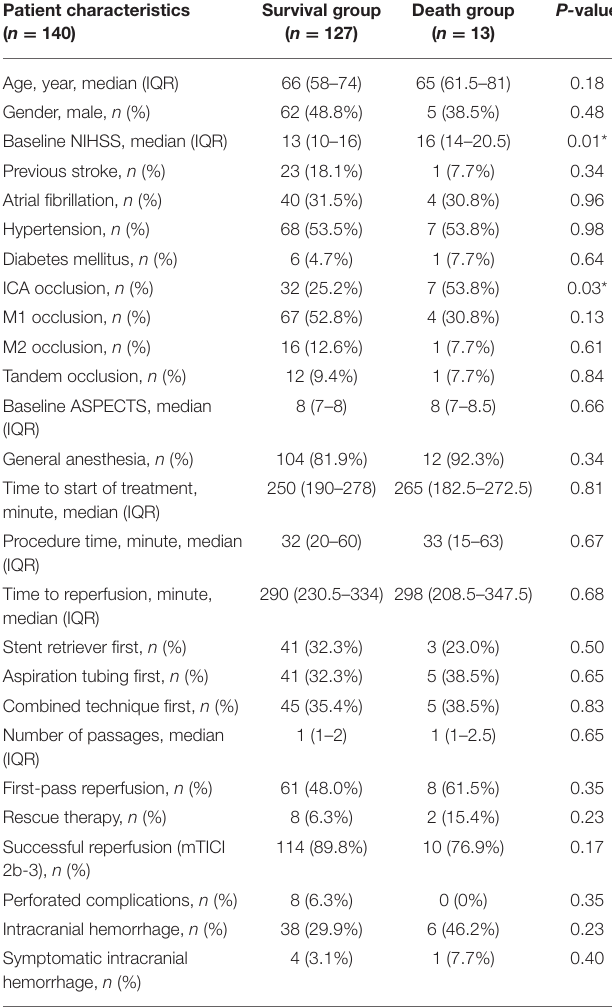
TABLE 4 | Factors associated with